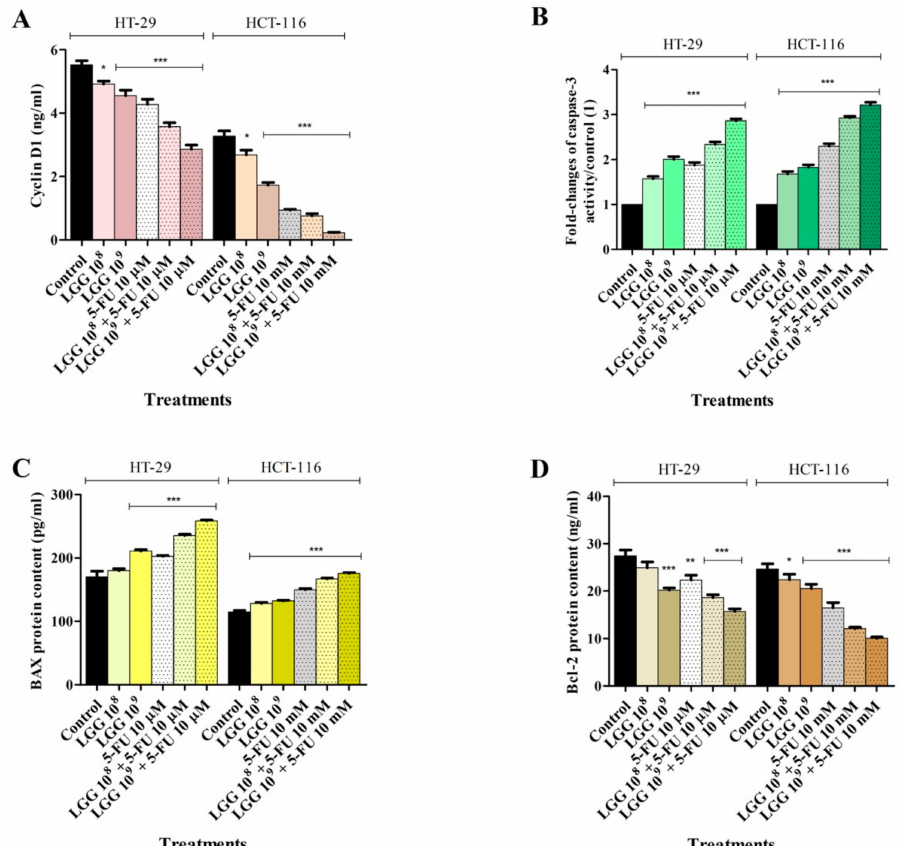
Figure 5. Effect of LGG (10 8 and 10 9 CFU/mL) ± 5-FU (10 µ M) on Cyclin D1 protein expression ( A ), caspase-3 activity ( B ) and BAX ( C ) and Bcl-2 ( D ) protein levels in HT-29 and HCT-116 colorectal cancer cell lines after 48 h treatment. The results were reported as mean values ± SD with p < 0.05 (*), p < 0.01 (**), p < 0.081 (***), when compared to control. All experiments were performed in